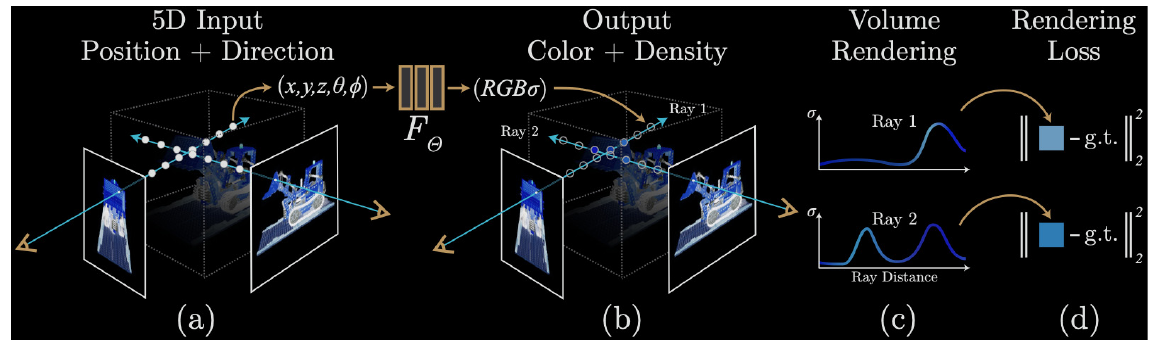
Figure 1. Overview of neural radiance field scene representation. Images are synthetized by sampling 5D coordinates (location and viewing direction) along camera rays, feeding these locations into an MLP to produce a color and volume density (left and center). Volume rendering techniques are used to composite these values into an